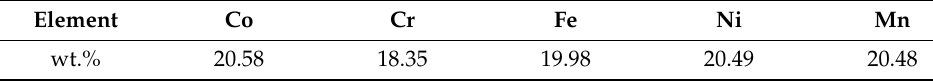
Figure 1. Microstructure of CoCrFeNiMn powder: ( a ) global morphology, ( b ) cross-sectional microstructure. Table 1. Composition of the CoCrFeNiMn high entropy alloy powder.